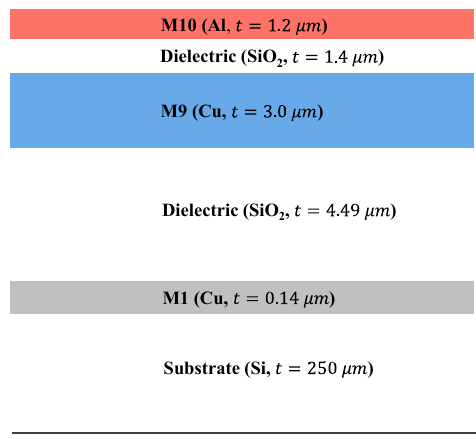
Figure 3. Cross-sectional view of the 65 nm Si CMOS process.